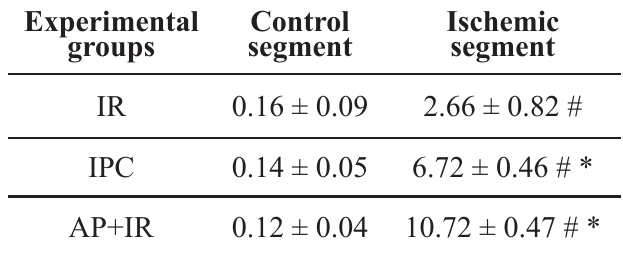
tABlE 2 - The number of apoptotic cells in mucosal villi of control and ischemic jejunum-segments of IR, AP+IR and IPC